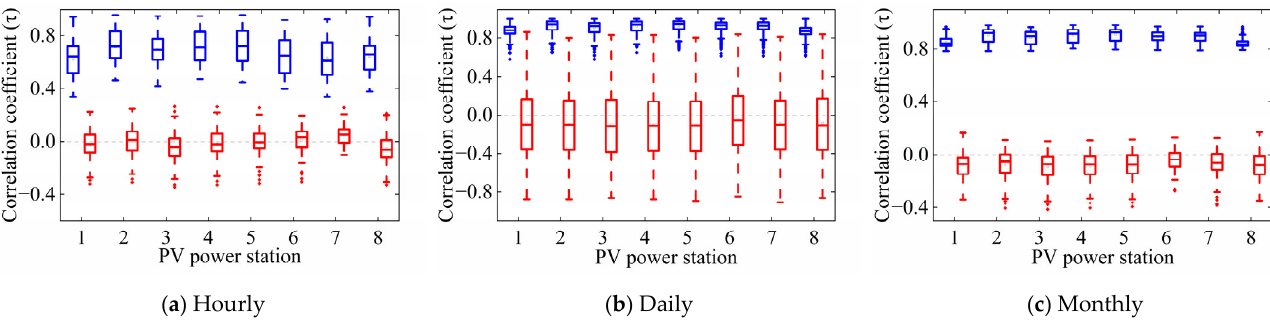
Figure 4. The fi rst type of complementary indicator under di ff erent time scales (the blue box Figure 4. The first type of complementary indicator under different time scales (the blue box repre- represents the solar-solar mode, and the red box illustrates the solar-wind mode). sents the solar-solar mode, and the red box illustrates the solar-wind mode).